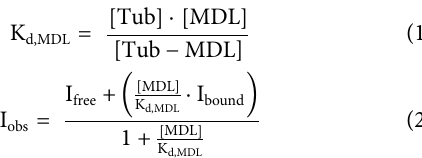
TABLE 1 | Inhibition of tubulin taxol-induced polymerization by colchicine-site drugs. Drug Brain tubulin (BTb) % inhibition at